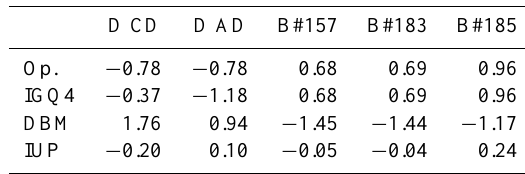
Table 10. Percentage Differences vs. the mean of Dobson (CD and AD pair labeled as D CD and D AD) and Brewer RBCC-E triad (B157, B183 and B185) instruments during the 2012 Izaña Lan- gley Dobson-Brewer campaign for the four cross sections used in this study: the operational for Dobson and Brewer instruments (Op), IGQ4, DBM and